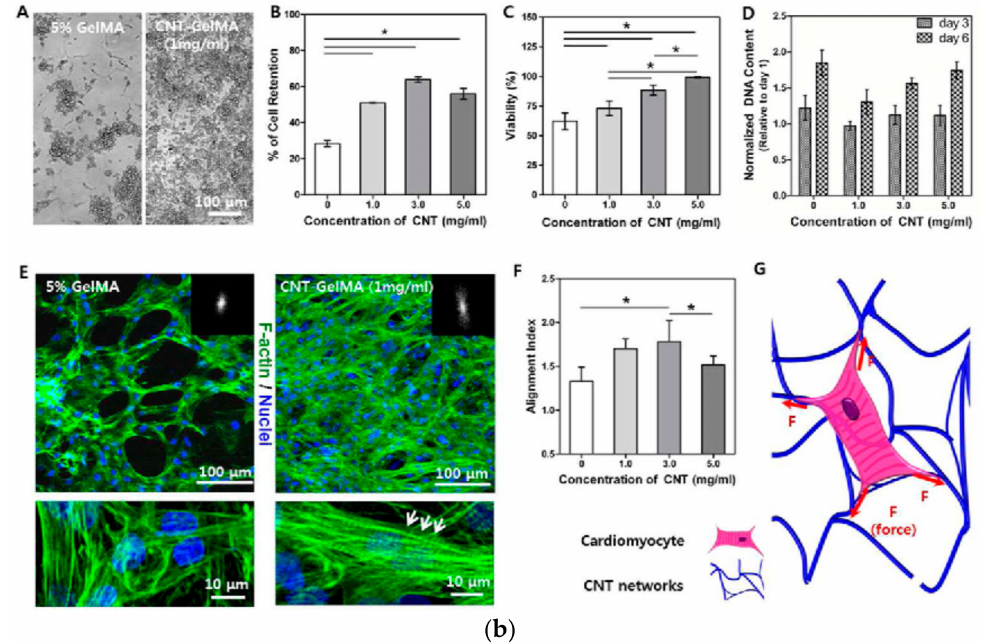
Figure 14. ( a ) Successfully synthesized CNT-GelMA conductive hydrogel and ( b ) improved cardiac cell adhesion and alignment on CNT-GelMA. In this study, CNTs improved cell-cell coupling and cardiac cell adhesion (reproduced from [167] with permission, copyright American Chemical Society,